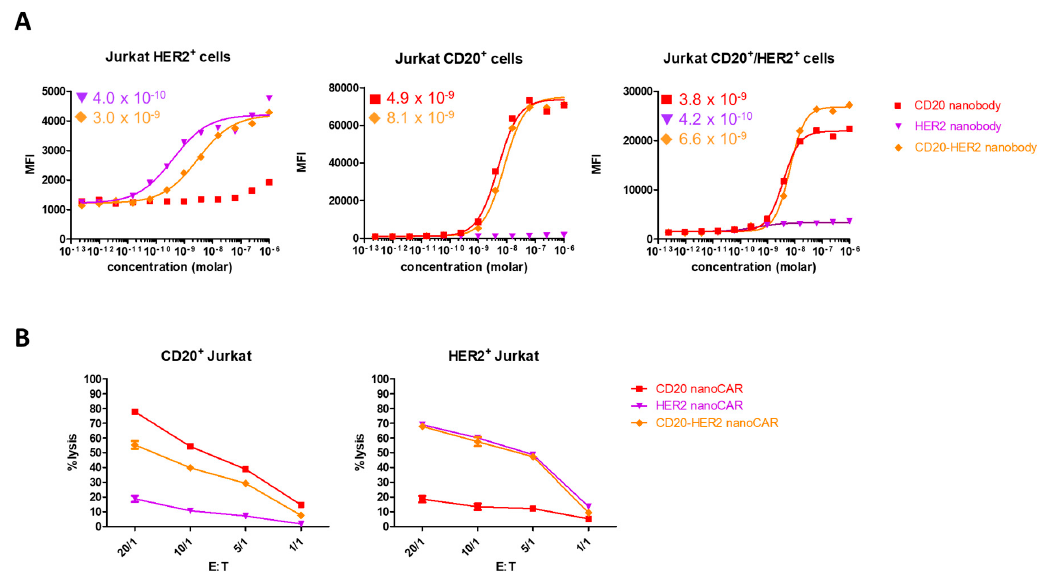
Figure 4. It is not the affinity of the different CAR structures that affects their function, but rather, the CAR structure. ( A ) Affinity determination of the monospecific of bispecific nanobody constructs. Affinities are shown in molar concentration. ( B ) Lysis by mono-specific or tandem nanoCAR T cells against Jurkat target cells expressing one antigen. Data show the mean values of duplicates and are representative of three independent experiments on three different donors.